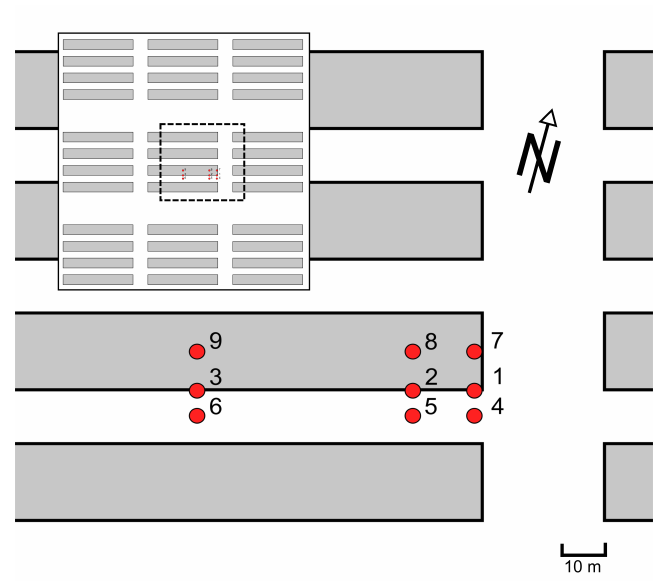
Figure A1. A plan view of the simplified digital building model showing the nine test sensor placements. Actual sensor placement at the Sperrstrasse canyon is approximated by number 3.